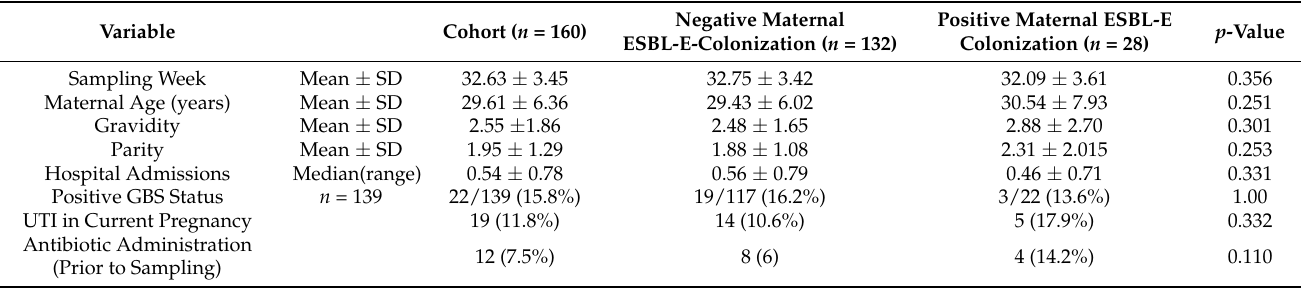
Figure 2. Proportion of extended-spectrum, beta-lactamase-producing Enterobacteriaceae (ESBL-E) isolates in maternal and neonatal colonization. Table 3. Association between maternal characteristics and ESBL-E colonization status.